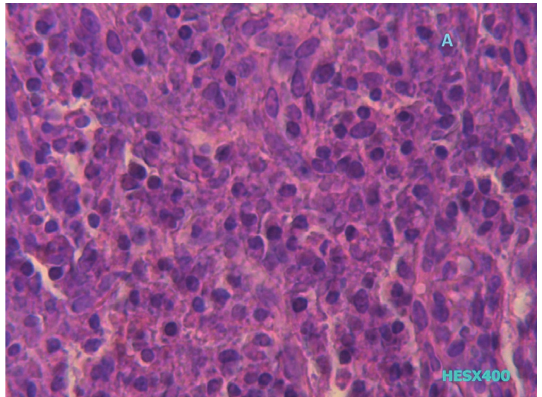
Figure 1: Histological examination of esophagus biopsy showing the presence of sheets of plasma cells.